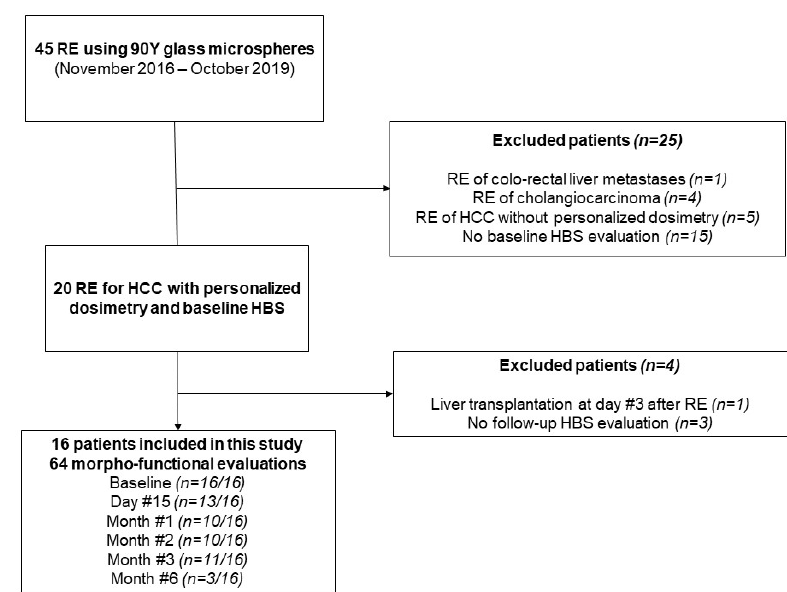
Figure 1. Study flow chart.